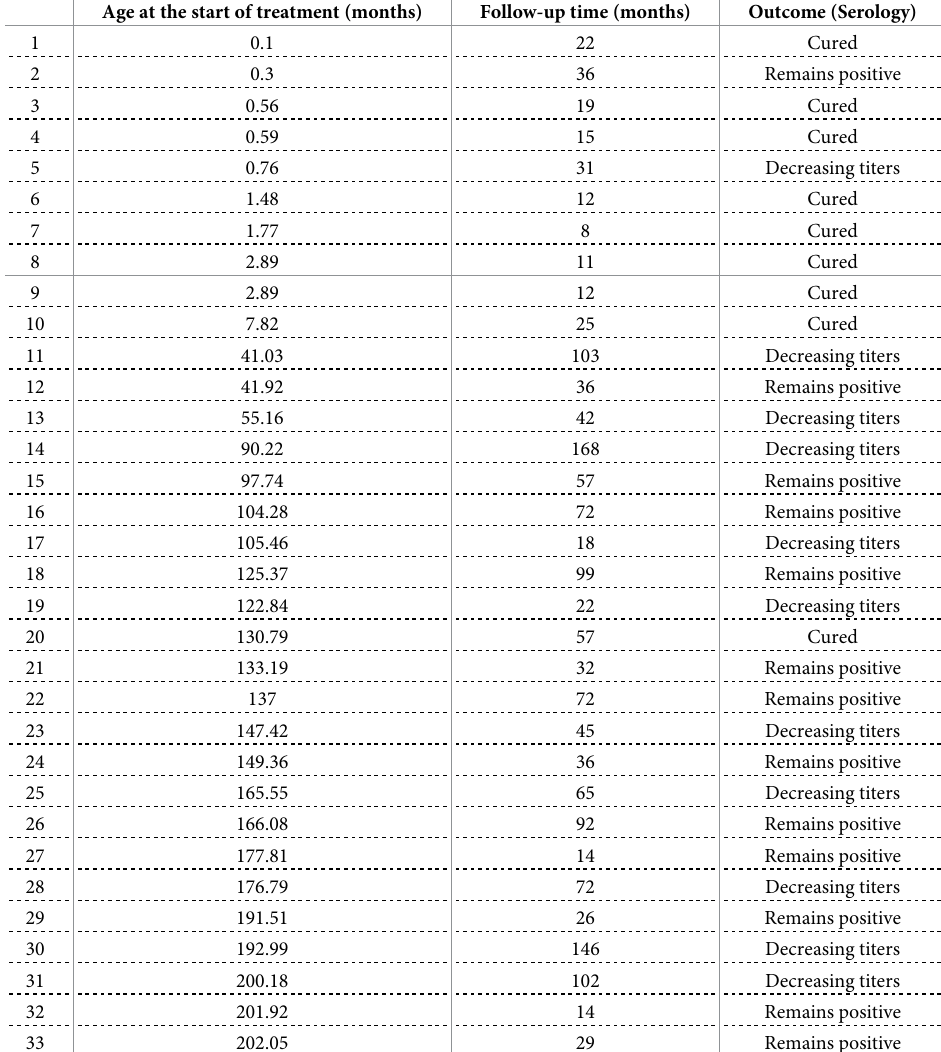
Table 2. Age at the start of treatment, time of follow up and outcome in the 33 patients that continued follow-up. Age at the start of treatment (months) Follow-up time